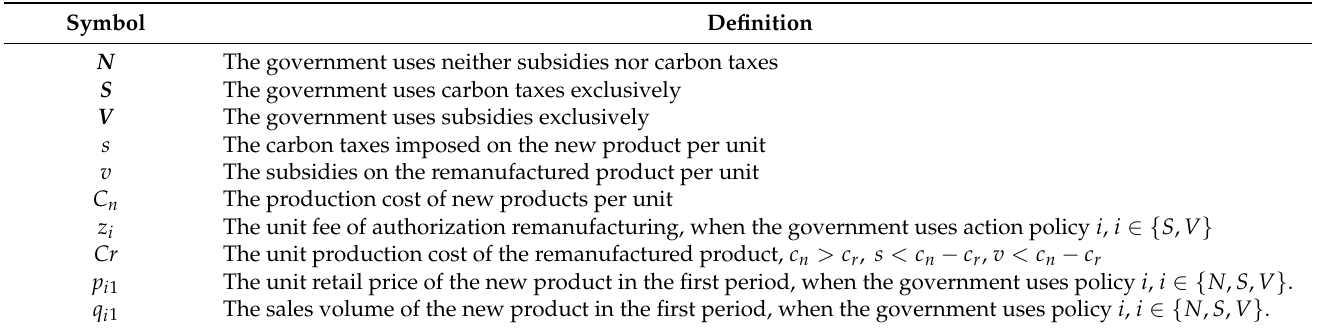
Table 1. Notation